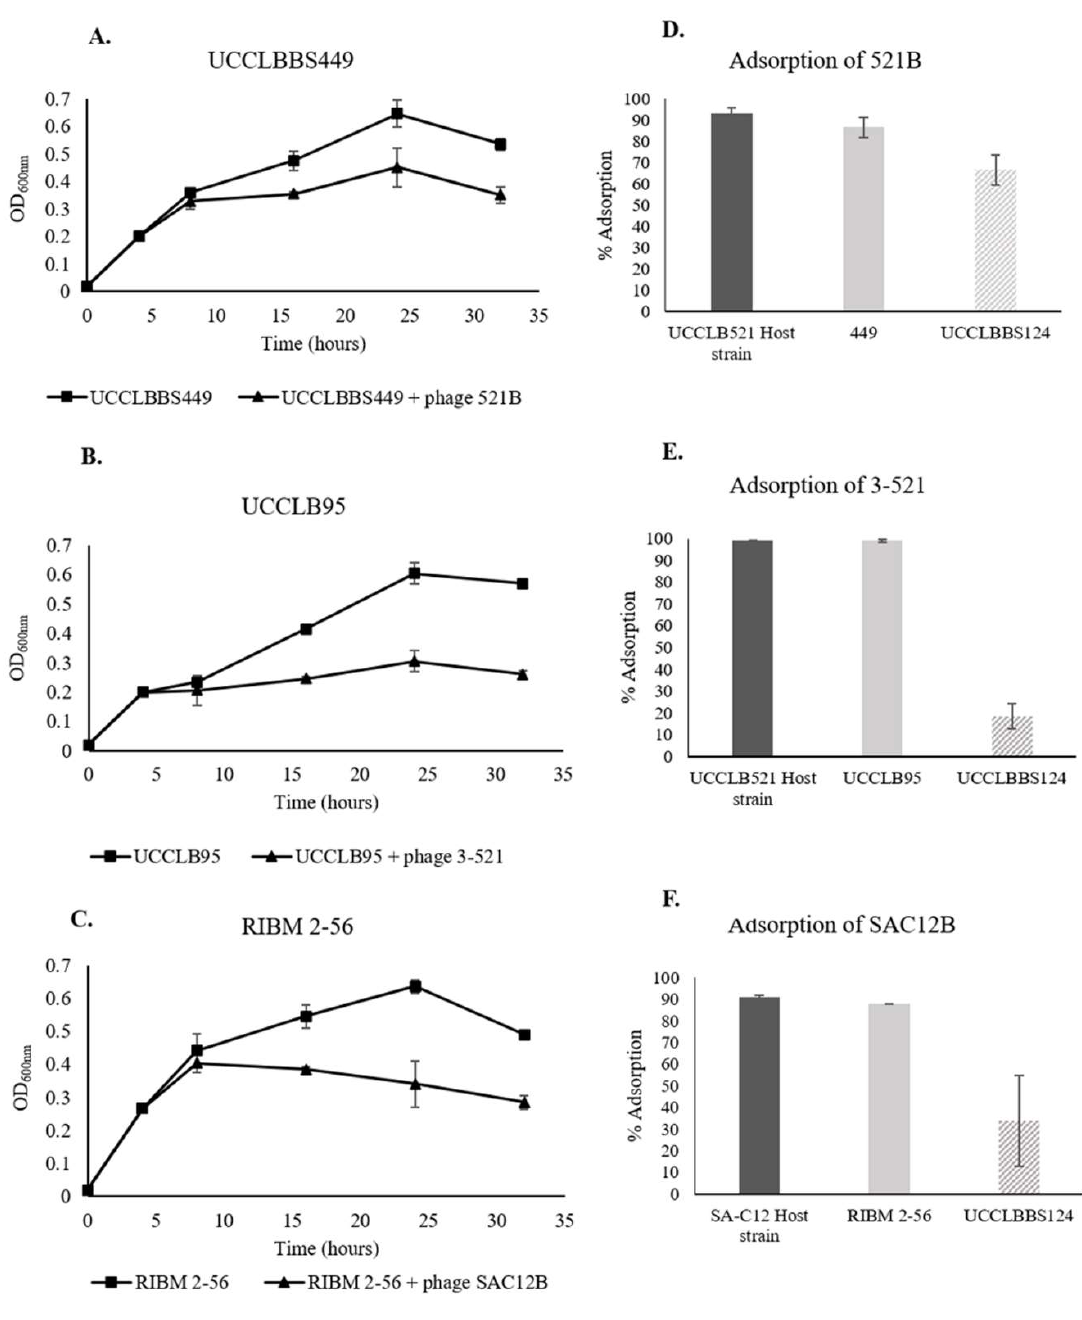
Figure 4. ( A – C ) Growth of Lb. brevis beer-spoiling strains when challenged with lytic phages (MOI = 1 when the culture reached an OD 600 nm of 0.2). A culture of the bacterial strain where no phage was added was used as a control. ( D – F ) Adsorption assays of lytic phages 521B, 3-521 and SAC12B onto Lb. brevis strains. Respective Lb. brevis host strains were used as positive control while Lb. brevis UCCLBBS124 was used as a negative control.